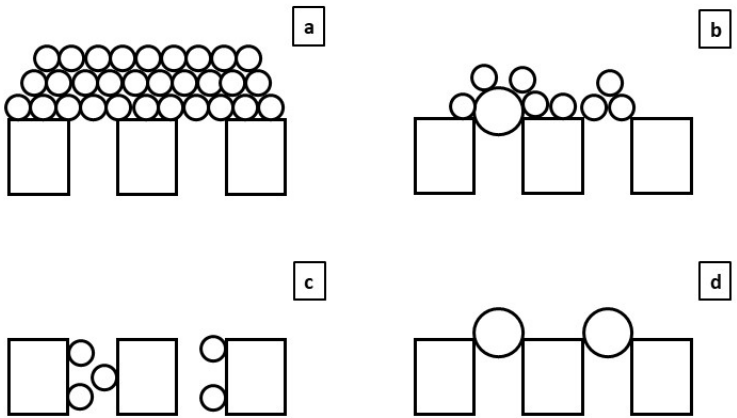
Figure 1. Fouling mechanism graphical scheme: ( a ) cake layer, ( b ) intermediate pore blocking, ( c ) standard pore blocking and ( d ) complete pore blocking. ( c ) standard pore blocking and ( d ) complete pore